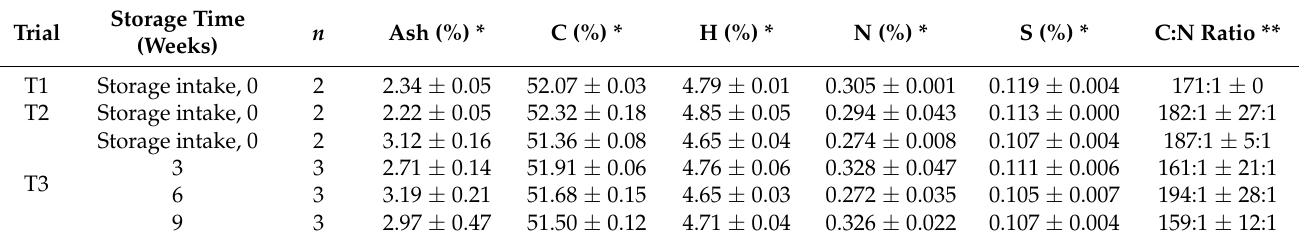
Table 3. Results of the elemental and ash analyses of poplar chips. (Mean ± standard